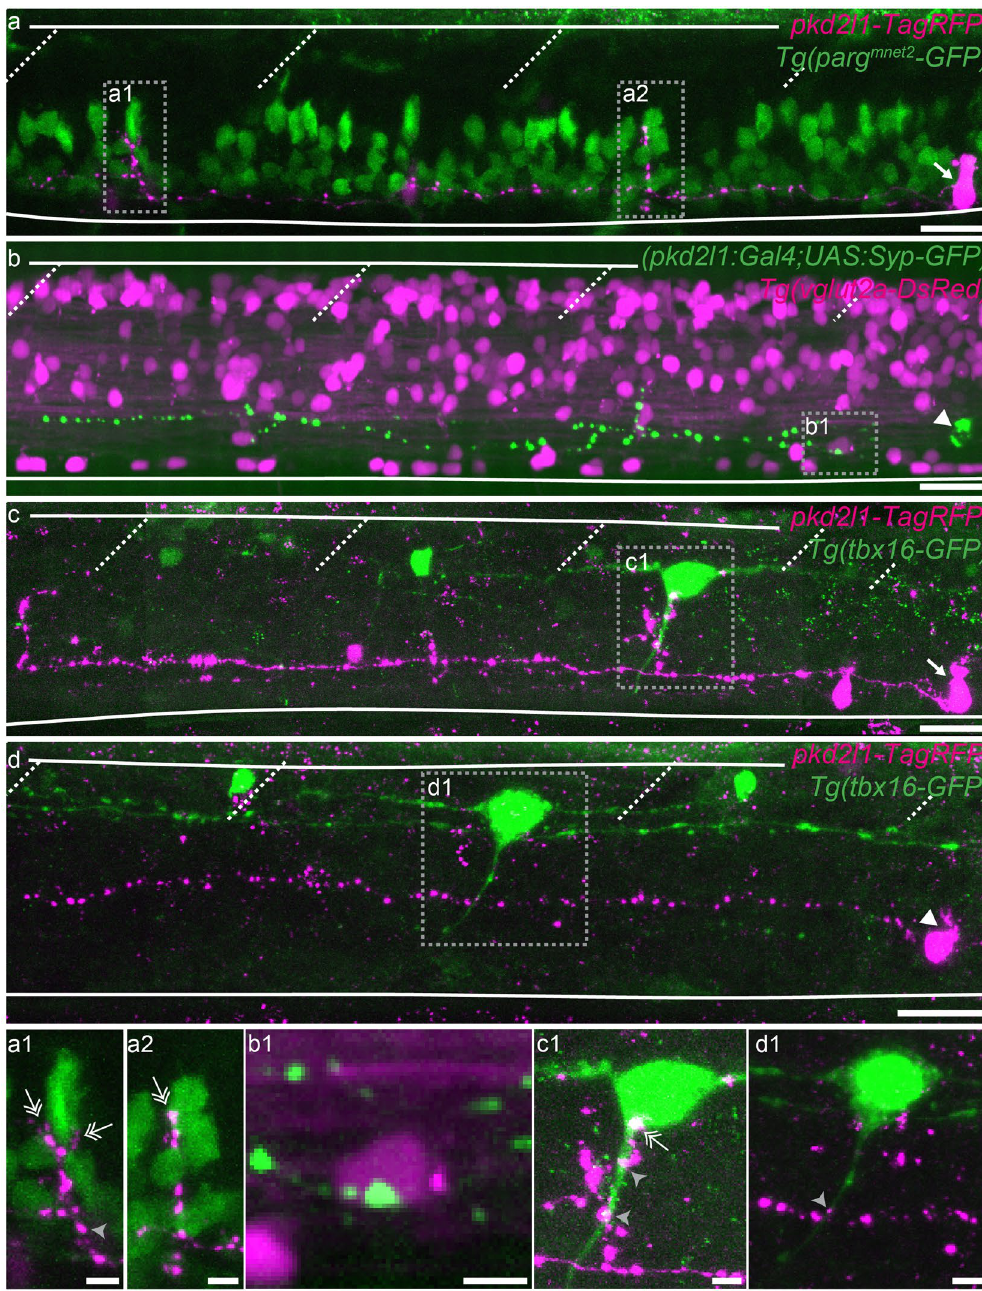
Figure 4. Ventral and dorsal CSF-cNs project onto distinct neuronal populations. ( a – d ) Z projection stacks showing contact from ventral and dorsal CSF-cNs onto different spinal targets. ( a ) Lateral view of a ventral CSF-cN (magenta, arrow) contacting 2 CaP motor neurons (identified based on their location within the segment) labelled in green in the Tg ( parg mnet2 -GFP ) transgenic line ( a1 , a2 , double headed arrows). ( b ) Dorsal CSF-cN (green, arrowhead) contacting a putative V0-v interneuron (magenta, based on its dorso-ventral and lateral location) in the Tg ( vglut2a : DsRed ) transgenic line. ( c , d ) Ventral ( c , arrow) and dorsal ( d , arrowhead) CSF-cNs (magenta) contact CoPA sensory interneurons (green) labelled in the Tg ( tbx16-GFP ) transgenic line. Boxes with close-ups highlight contacts between the CSF-cN and its target. Scale bar = 20 µ m ( a – d ) and 5 µ m ( a1 – d1